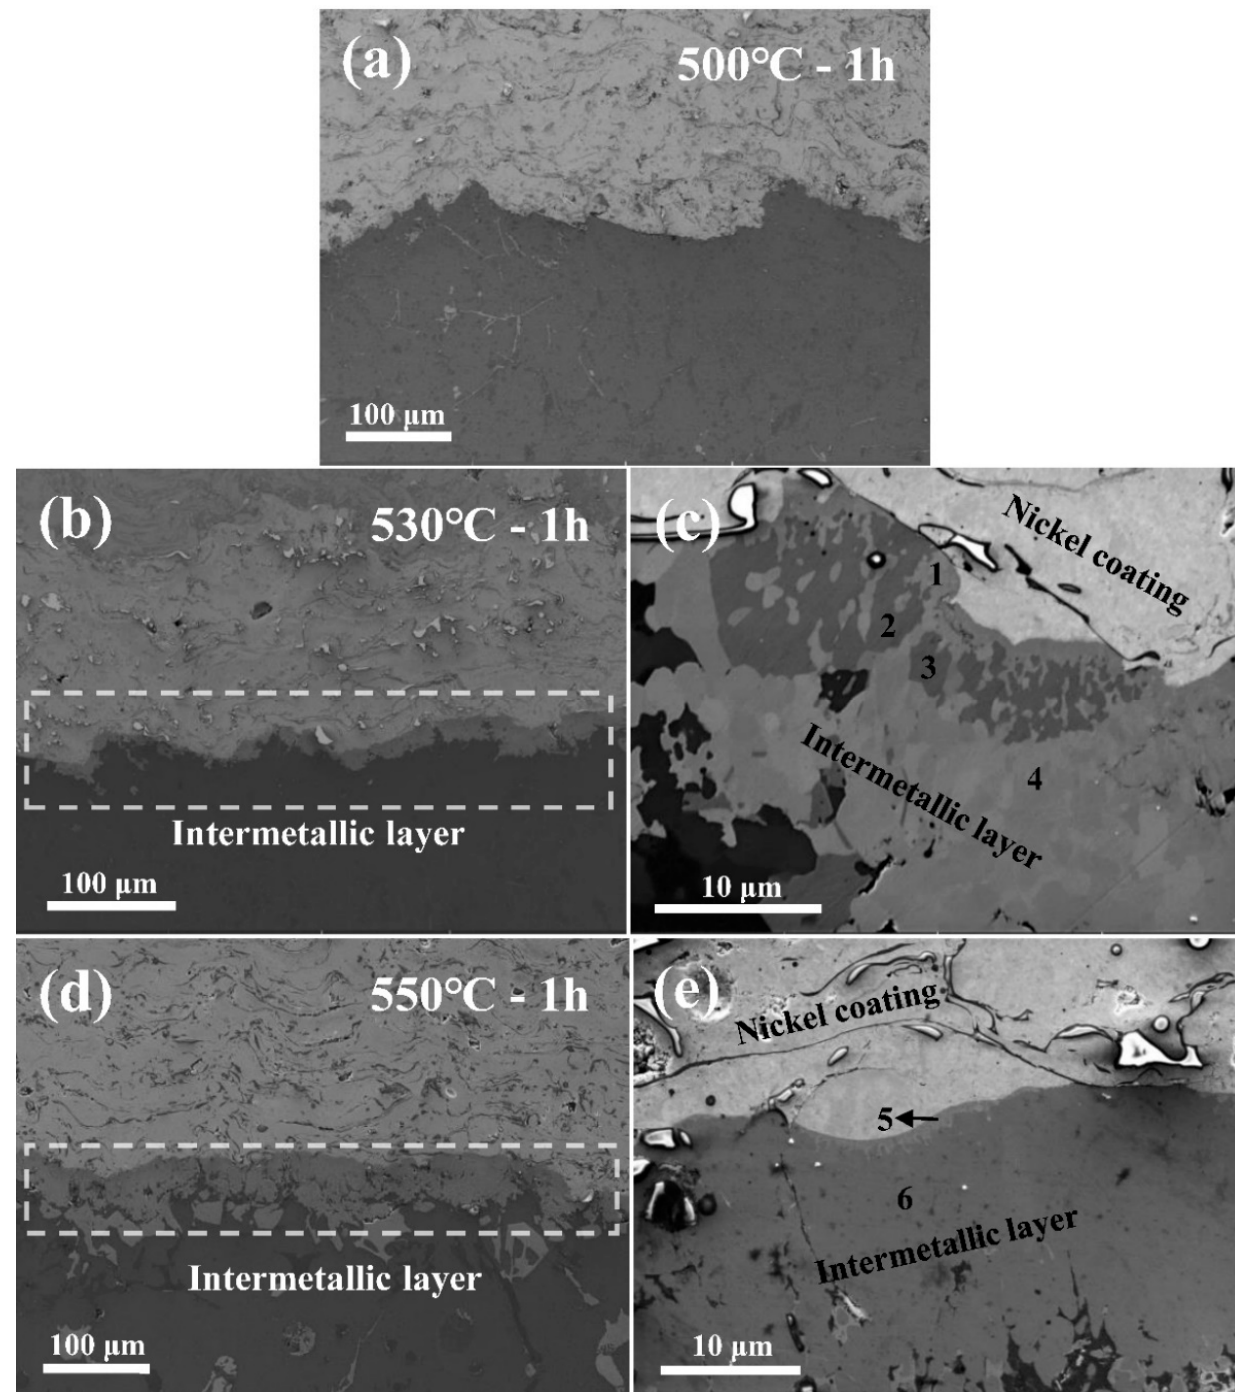
Figure 2. SEM micrographs of the Al/Fe alloys hybrid structure’s interface under different solution temperatures followed by furnace cooling; ( a ) 500 °C, ( b , c ) 530 °C, and ( d , e ) 550 °C.